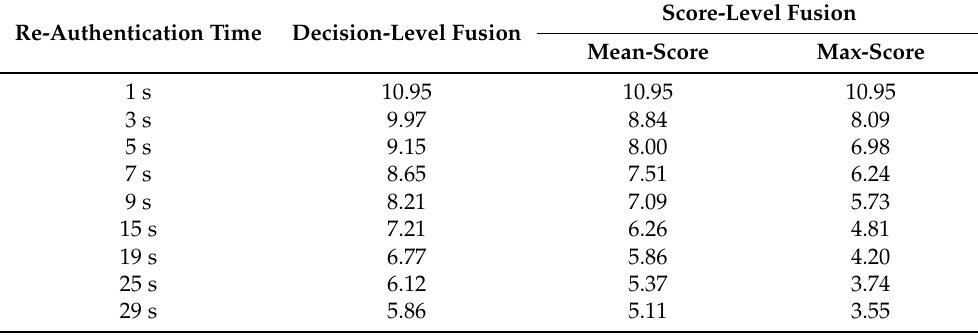
Table 5. Averaged EERs ( % ) of the decision and score-level fusion for different re-authentication times. Re-Authentication